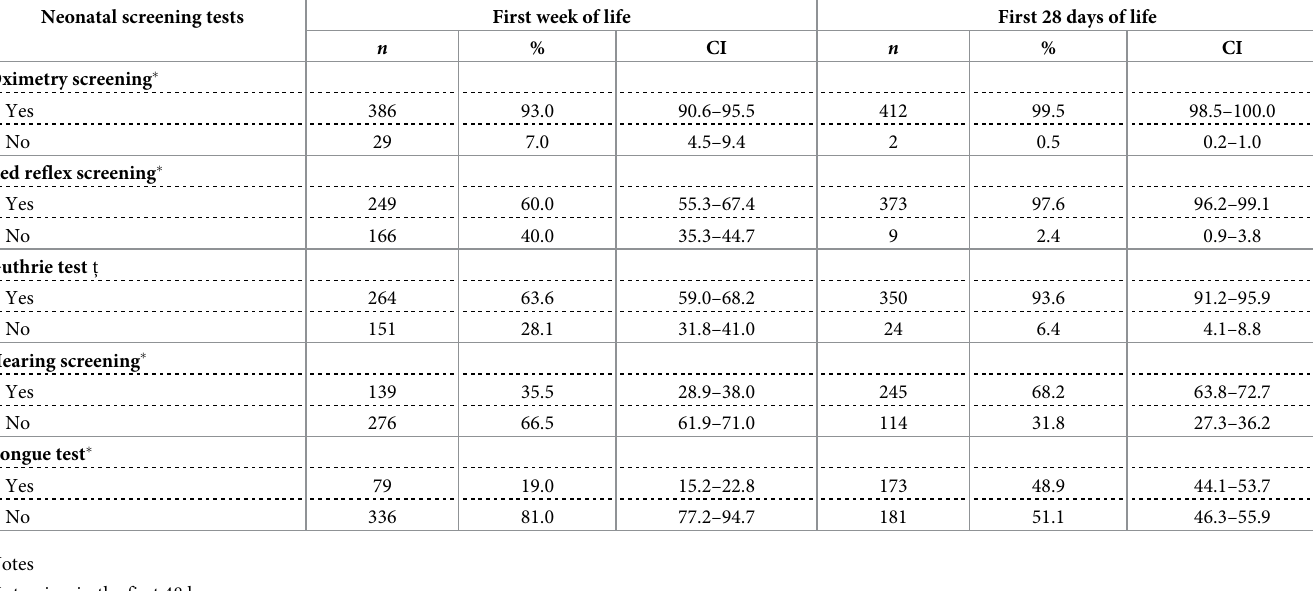
Table 1. Completion frequency of neonatal universal screening tests (first 28 days of life) in Natal, Brazil, 2019 (n = 415). Neonatal screening